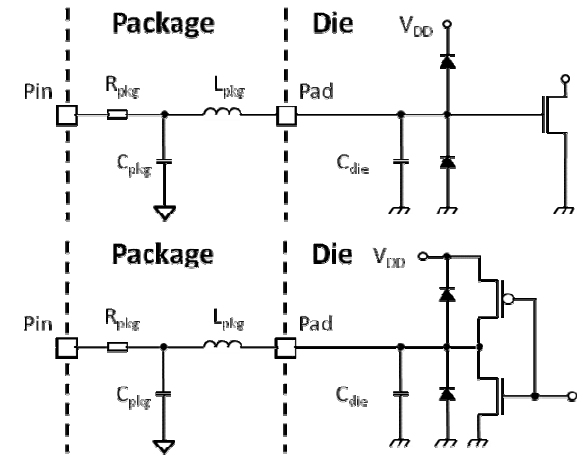
Figure 1: IBIS general structure of a